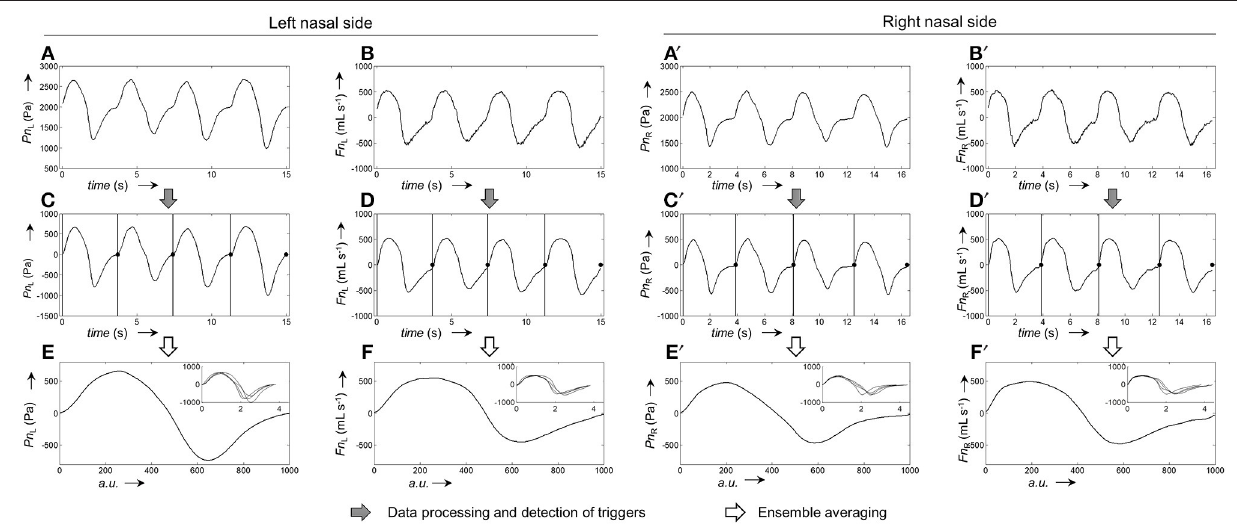
FIGURE 3 | Representative example for the generation of pressure and airflow signals during one averaged breath used for the calibration of left and right nasal sides. (A,A’) , Raw recordings of left and right nasal pressure, respectively. (B,B’) , Raw recordings of left/right nasal airflow. (C,C’) , Left/right nasal pressure recordings after application of signal correction steps (filtering, offset correction, cross-correlation); the vertical bars and black dots, respectively, indicate the positions at which the signals were cut into the individual breaths (vertical lines: start of breath, dots: end of breath). (D,D’) , Left/right nasal airflow recordings after application of signal correction steps (same as for pressure recordings). (E,E’) , Ensemble average of the left/right nasal pressure during one breath, normalized to 1,000 data points. (F,F’) , Ensemble average of left/right nasal airflow during one breath, normalized to 1,000 data points. The ensemble averaged curves were obtained from the individual breaths shown as overlays in the respective insets.